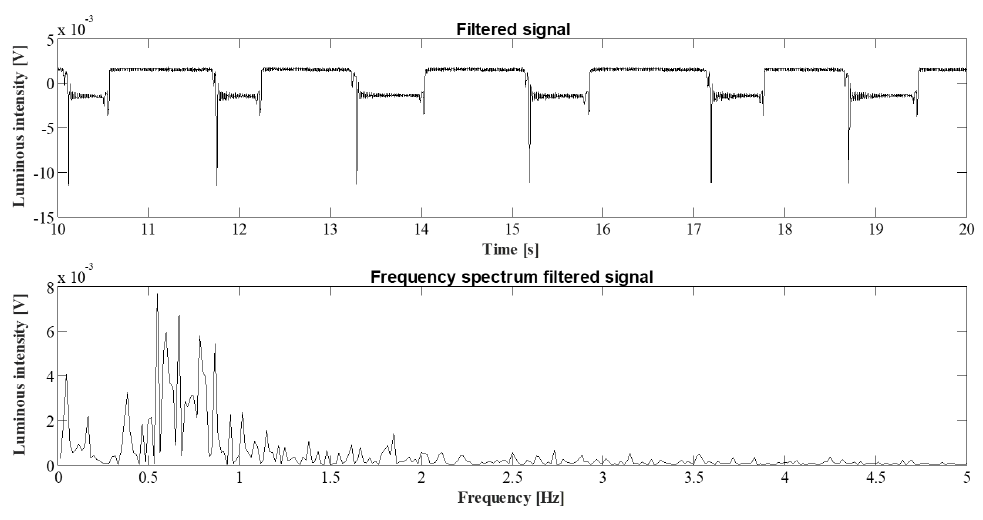
Figure 1. Flow diagram of the experimental set-up: the two syringe pumps, the microfluidic channel, the opto-mechanical block and the optical acquisition. Two algorithms were developed: one to control the syringe pumps actuation ( Control Law ) and the other to detect the frequency of the slugs passage ( Soft Sensor ) in the straight part of the micro-channel.